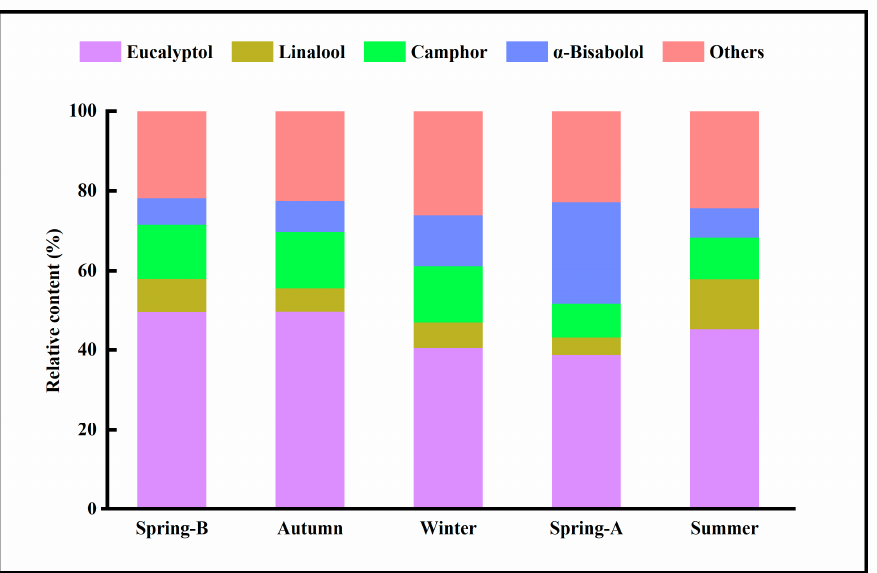
Figure 3. Seasonal variation of the main characteristic components and relative contents in La- vandin essential oils. essential